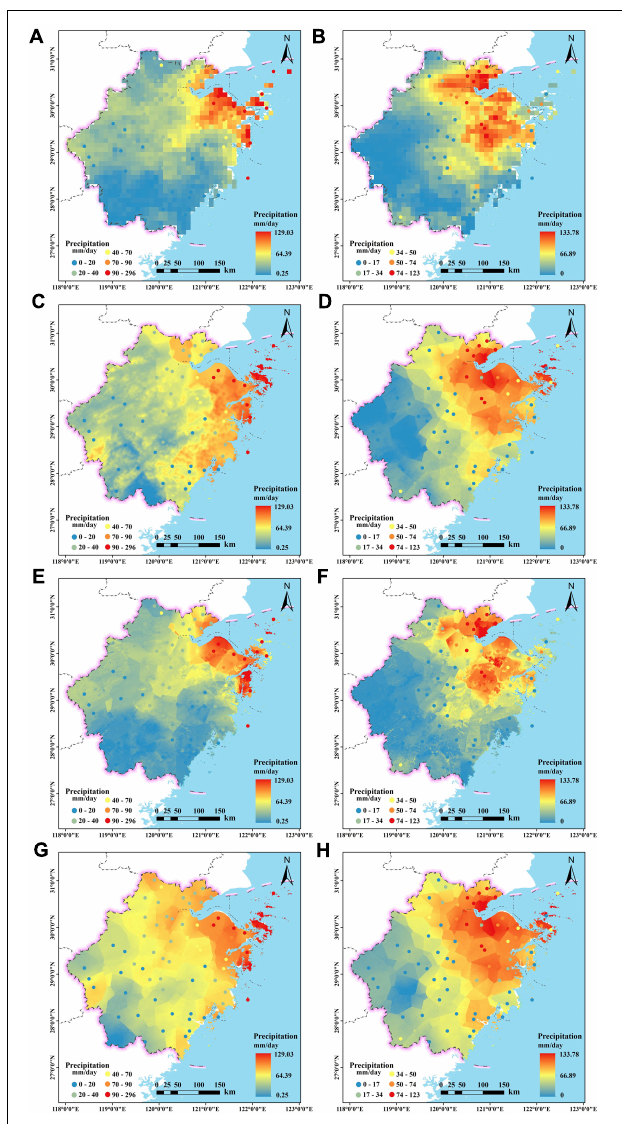
FIGURE 8 | The spatial patterns of (A,B) the original IMERG in event 2 and event 4, (C,D) BPNN-based downscaled results in event 2 and event 4, (E,F) SVM-based downscaled results in event 2 and event 4, and (G,H) MLR-based downscaled results in event 2 and event 4 over Zhejiang Province.